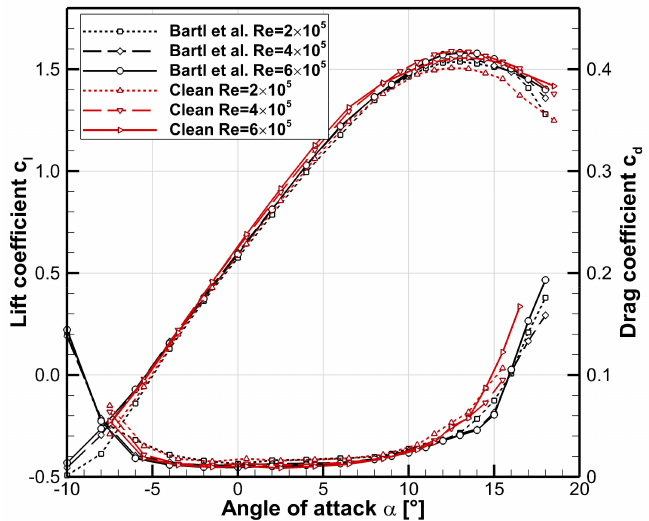
Figure 5. Comparison of experimental results to Bartl et al. for Re = 2 × 10 5 , 4 × 10 5 , and 6 × 10 5 . Data adapted from